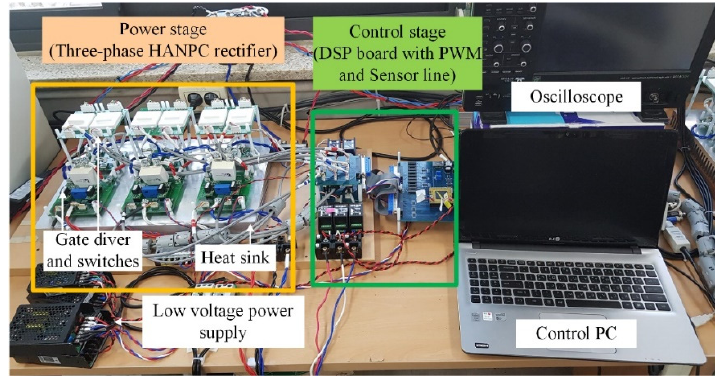
Figure 15. Experimental setup of three-phase HANPC rectifier system.